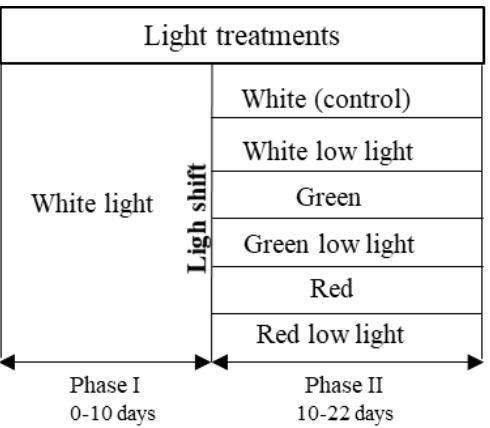
Figure 1. Scheme of experimental design regarding light treatments applied to S. salina LEGE 06155 cultures: white (control, 150 μmol photons ·m – 2 ·s – 1 ), white low light (50 μmol photons ·m – 2 ·s – 1 ), green (150 μmol photons ·m – 2 ·s – 1 ), green low light (50 μmol photons ·m – 2 ·s – 1 ), red (150 μmol photons ·m – 2 ·s – 1 ), and red low light (50 μmol photons ·m – 2 ·s – 1 ).